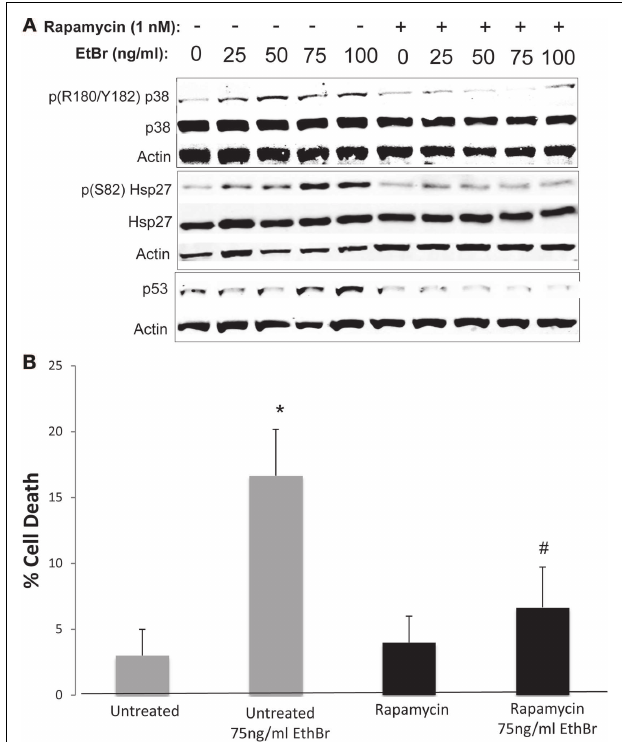
FIGURE 8 | Stress kinase signaling, p53 levels, and cell viability following ethidium bromide exposure . Human fibroblast cell cultures grown in the presence or absence of 1nM rapamycin were exposed to increasing doses of ethidium bromide for a period of 7days. (A) Total cellular protein extracts were prepared and analyzed by immunoblot as described in Section “Materials and Methods” for a subset of mitochondrial resident proteins.The levels of beta-actin are presented as a control for equal protein loading.The immunoblot presented is a representative blot of a minimum of two measurements with similar results. (B) Cells were examined for viability using a trypan blue exclusion assay. Gray bars indicate control cultures and black bars indicate rapamycin treated cultures. The concentration of ethidium bromide is indicated beneath each bar. Differences between cultures exposed to ethidium bromide and unexposed cultures, which are significant at P < 0.05 are indicated by an asterisk and differences between control and rapamycin treated cultures under identical conditions are indicated by a pound